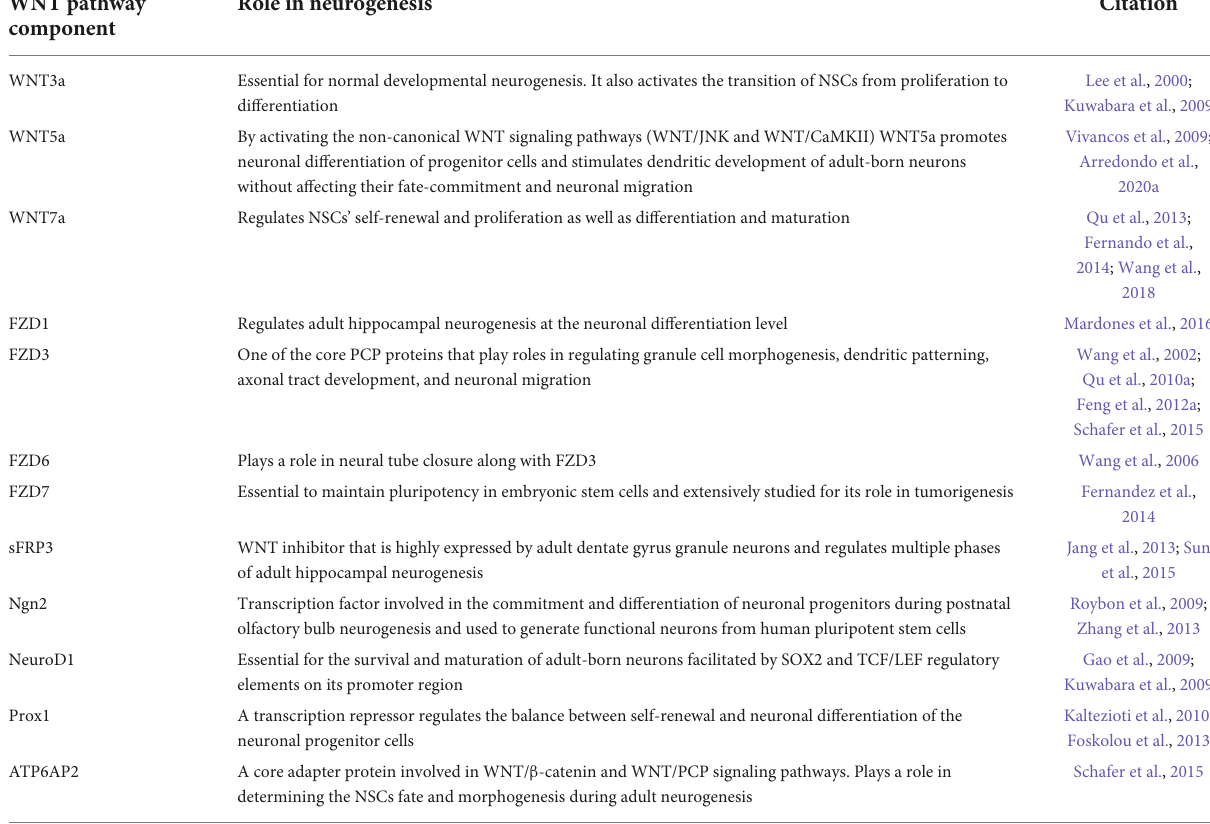
TABLE 1 Role of WNT components in